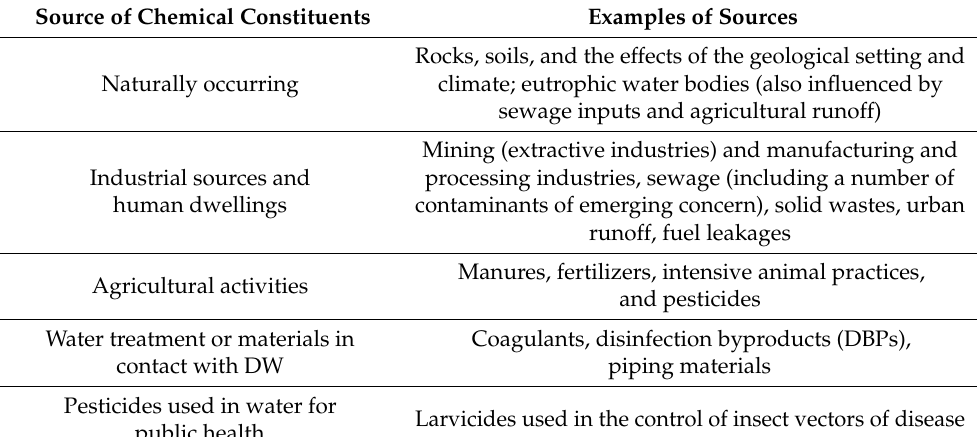
Table 1. Categorization of source/origin of chemical compounds contaminating DW